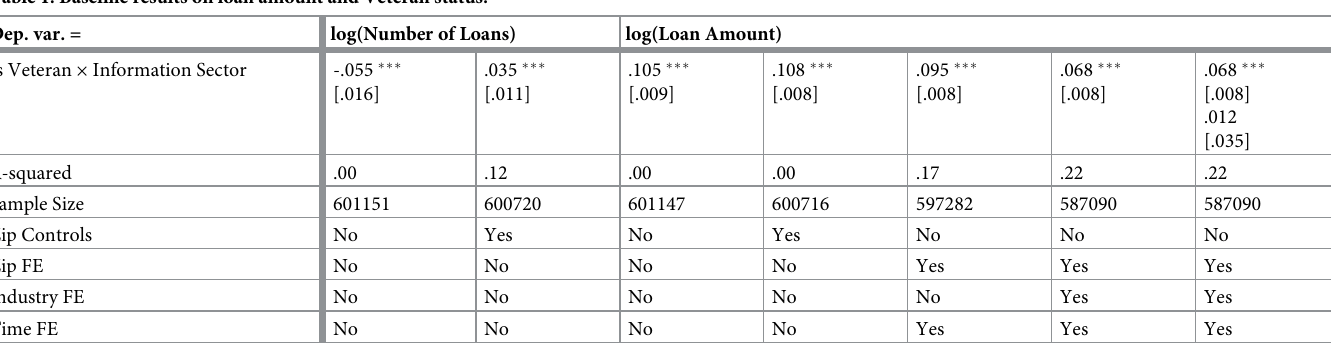
Table 1. Baseline results on loan amount and Veteran status. Dep. var.